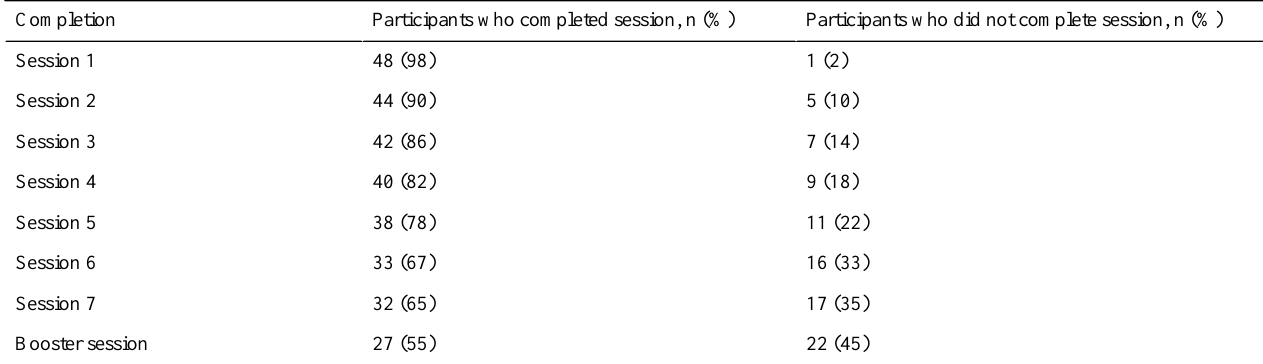
Table 5. Completion